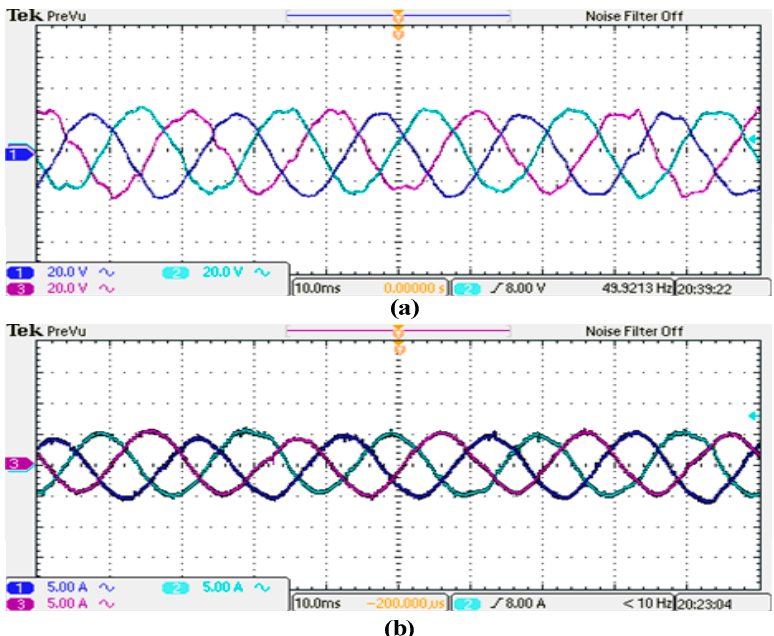
Figure 26. DFIG system in weak grid with high bandwidth SRF-PLL ( a ) Stator voltage, ( b ) Stator current.